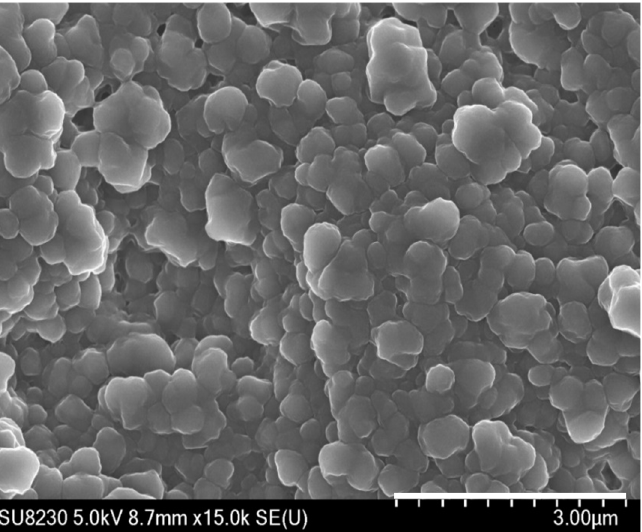
Figure 5. A top surface view by SEM imaging for plasma-synthesized AlN-rich coating on carbon steel in ×15,000 magnification.